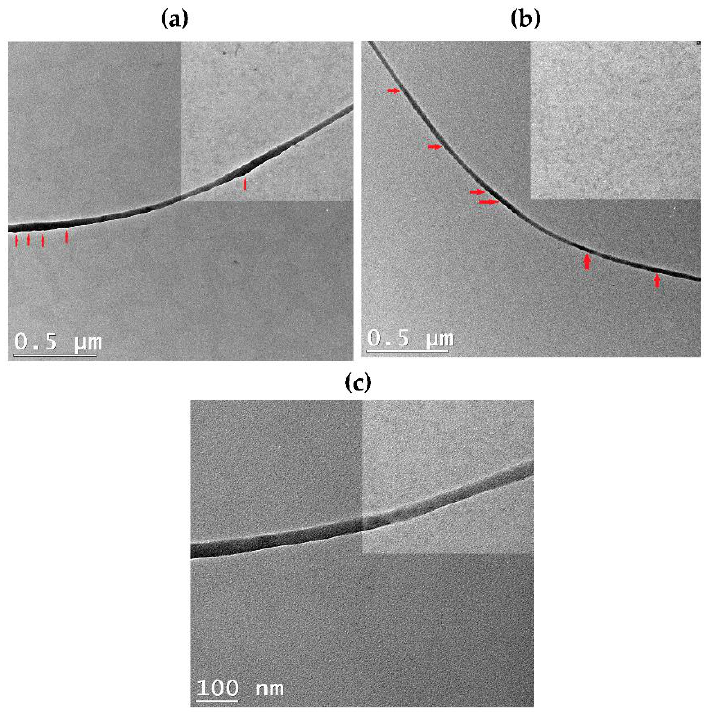
Figure 7. ( a – c ) High-resolution TEM images of PANI/PMMA/Am-rGO nanofibers at different Figure 7. ( a – c magnification.